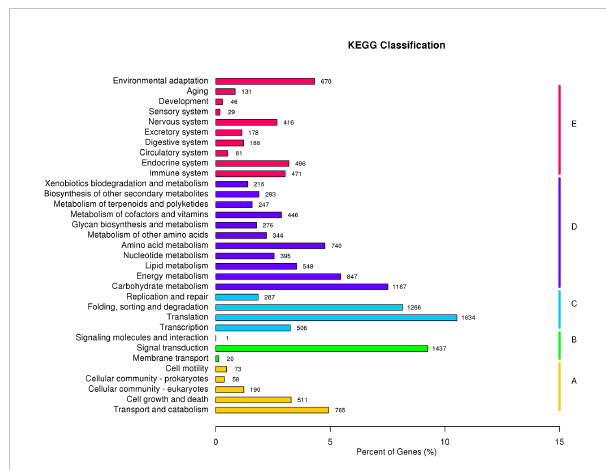
FIGURE 4 KEGG (Kyoto encyclopedia of genes and genomes) classi fi cation of Mango transcriptome.